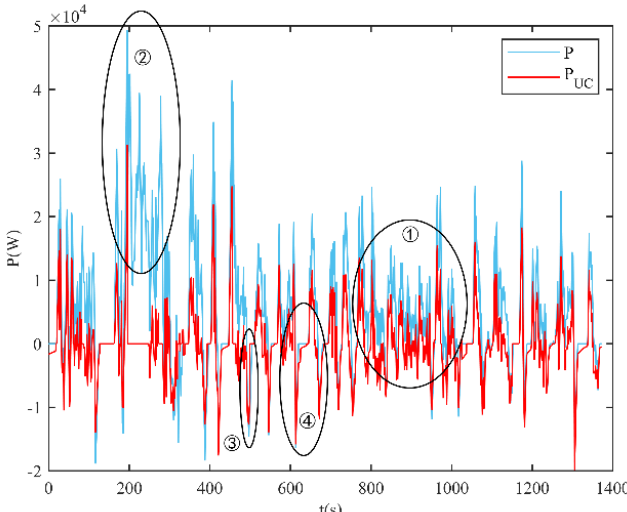
Figure 8. The curves of the UC output power and the total power demanded under UDDS.